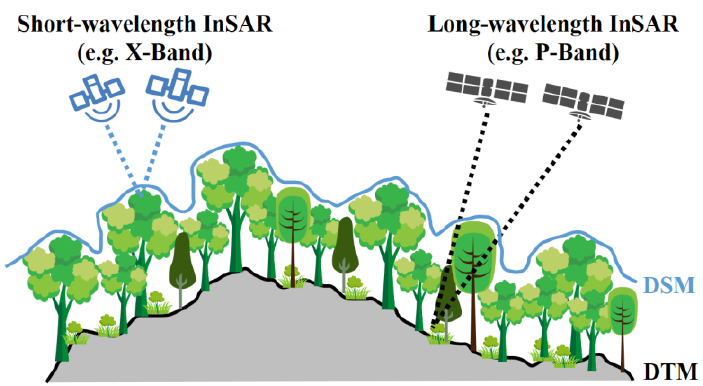
Figure 1. Schematic diagram of estimating forest height using the penetration differences of differ- ent wavelength InSARs. wavelength